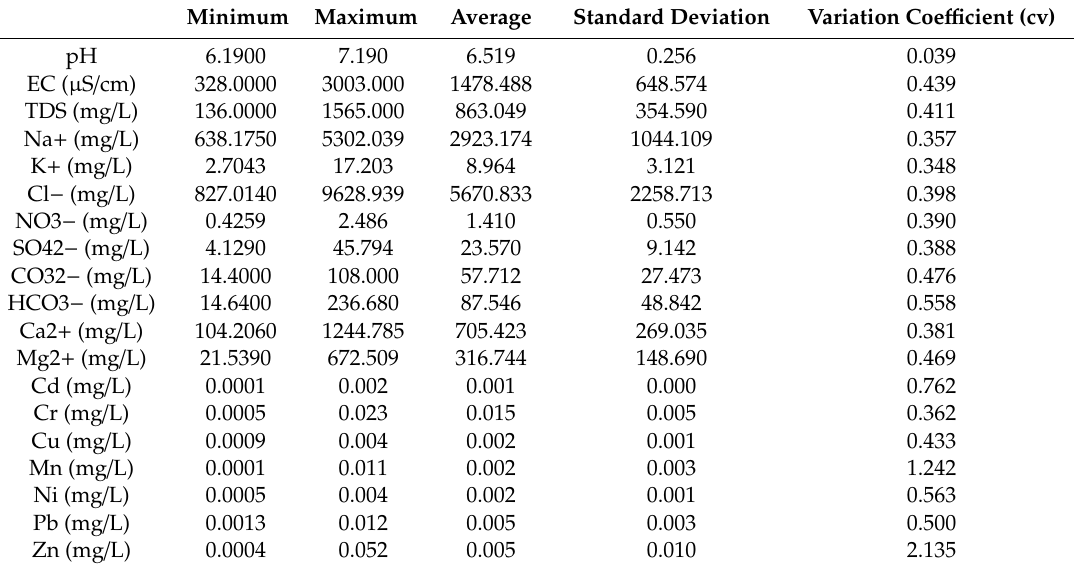
Table 2. Basic statistics of the water